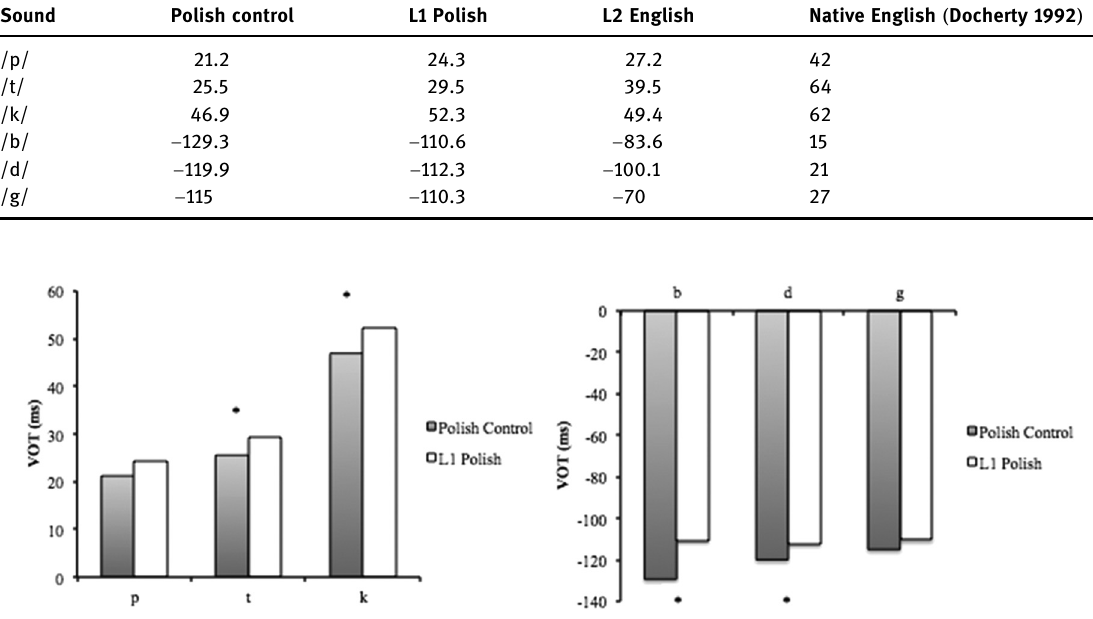
Figure 2: L1 Polish stops compared to the Polish control ( left – voiceless stops; right – voiced stops ) .